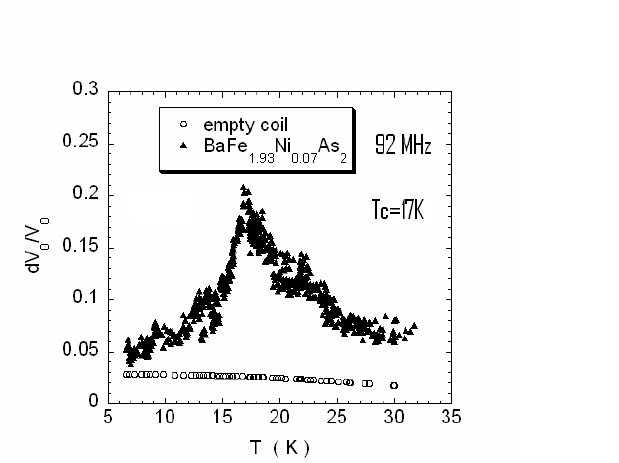
Figure 1: Temperature dependence of the relative change dV 0 /V 0 , LC circuit measured at 92 MHz with BaFe 1.93 Ni 0.07 As 2 crystal dimensions 7x5x0.2 mm 3 , superconducting phase transition T C = 17 K and the empty coil.